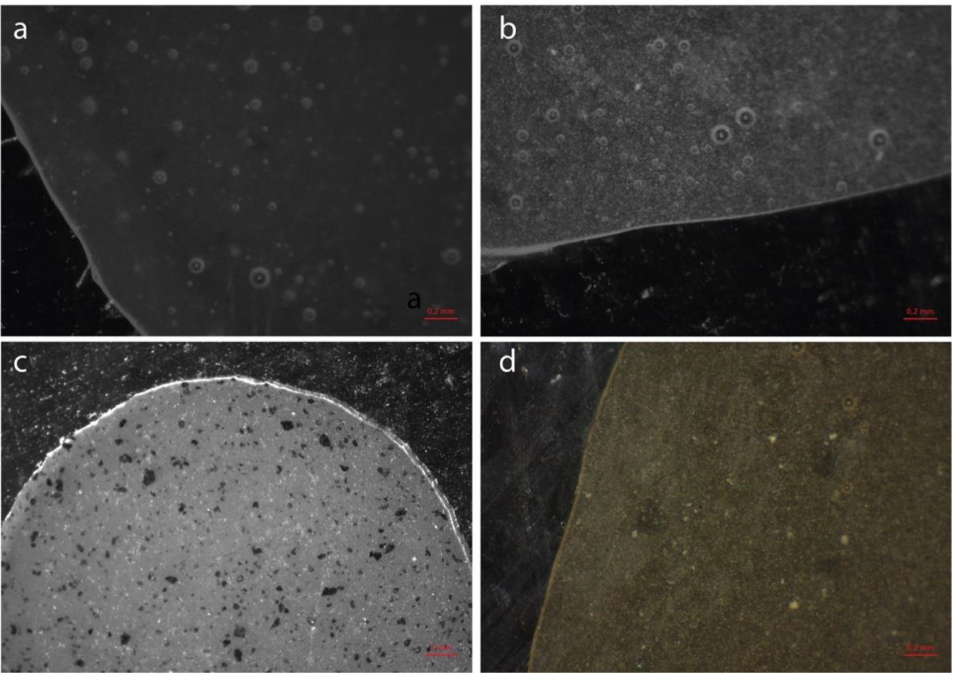
Figure 5. Light microscope images of ( a ) base paste and ( b ) catalyst of the CBC before degasification showing the composite fillers embedded in the resin matrix. ( c ) Image of base paste of CBC 2% FGm under optical microscope; note the relatively large size of the micronized fluorographene and graphene clusters (black particles). ( d ) Image of catalyst paste of CBC 2% FGe; exfoliated FG clusters are far beyond the optical microscope resolution.